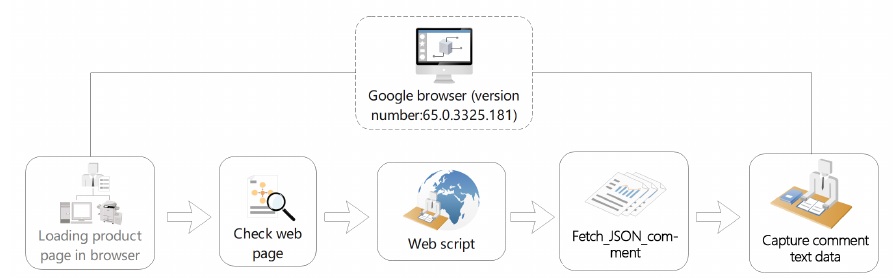
Figure 2. Steps for review data